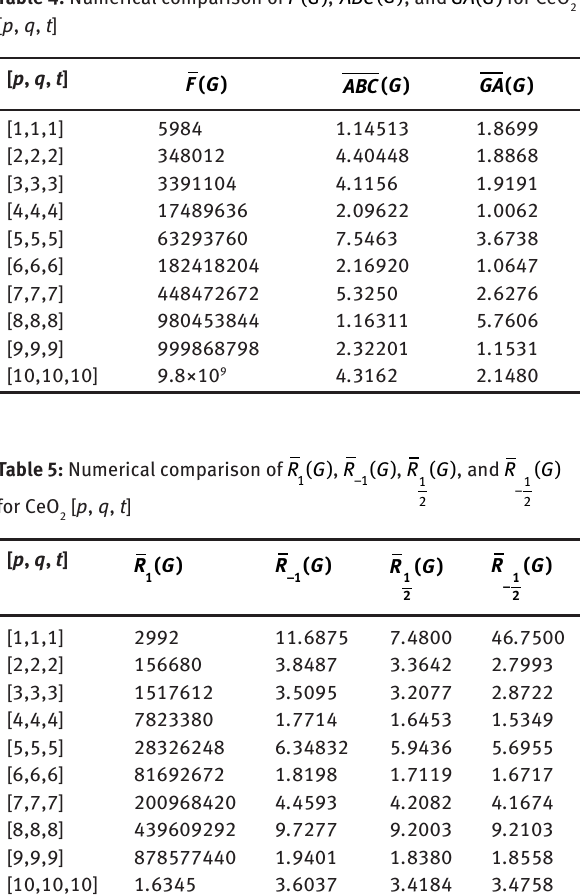
Table 4: Numerical comparison of F G ( ), ABC G ( ), and GA G ( ) for CeO